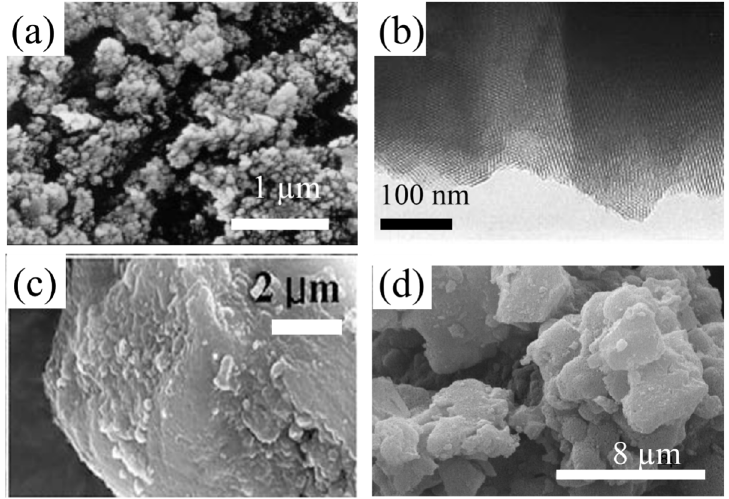
Figure 3. ( a ) Scanning electron microscopy (SEM) and ( b ) transmission electron microscopy (TEM) image of MCM-41 particles (Reproduced with permission from [47].